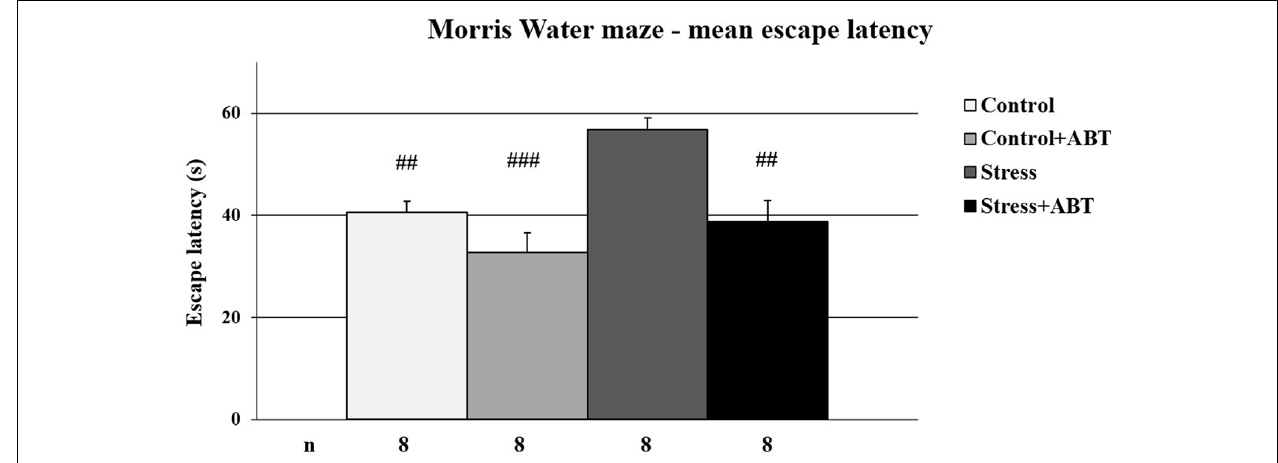
FIGURE 1 | Effects of chronic stress and long-term ABT-239 pre-treatment on performance in spatial memory test of the Morris water maze (MWM) task. Each column represents the mean ± SEM of nine trials (three trials per day for 3 days) obtained from n rats indicated at the bottom of the figure. The three groups demonstrated significantly different results in latencies of reaching submerged platform in the water maze in comparison with stress: ## p < 0.01 vs. Control, p < 0.01 vs. Stress + ABT and ### p < 0.001 vs. Control + ABT.